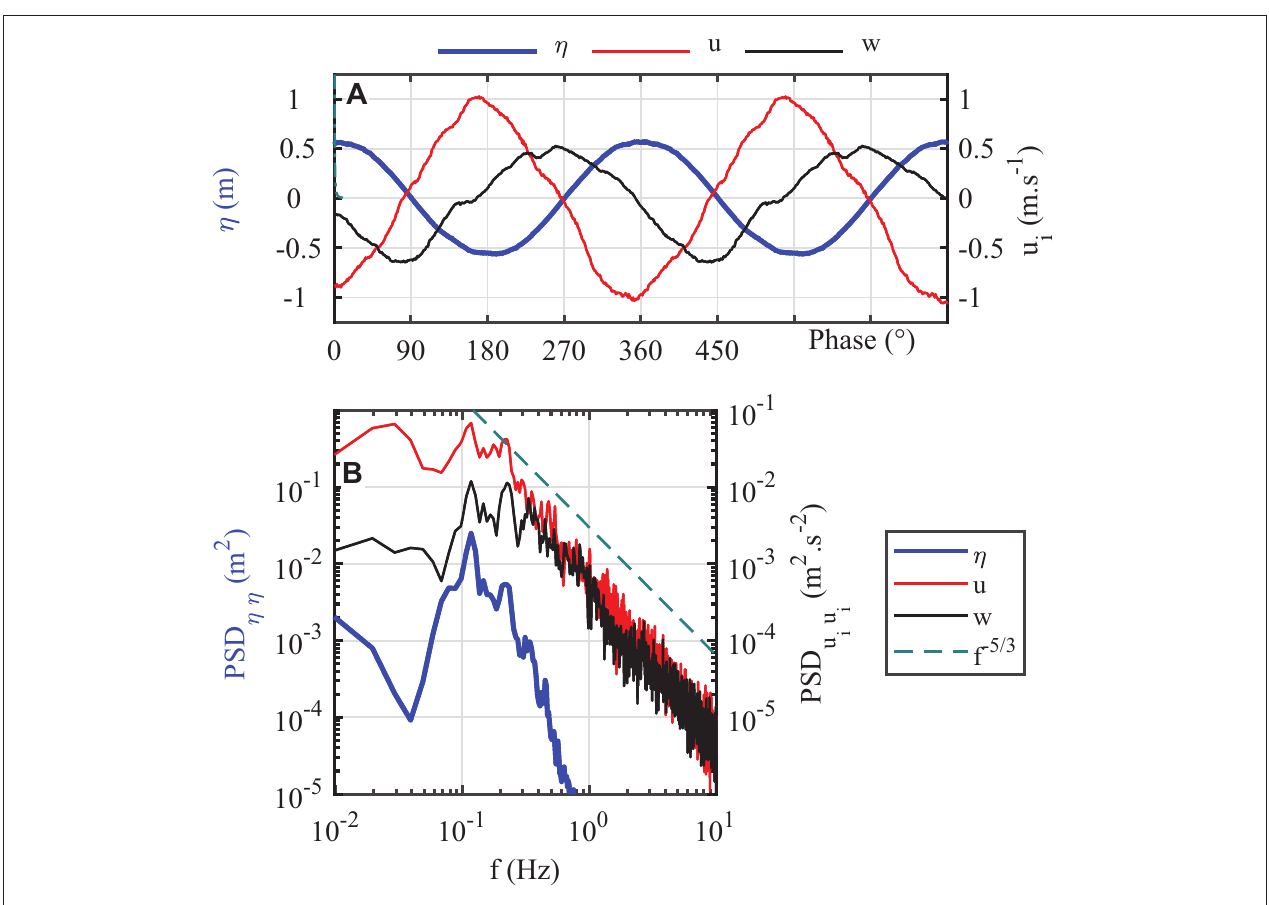
FIGURE 8 | Wind turbulence measurements from the Gill R3-50 three-dimensional ultrasonic anemometer on the SV2 Wave Glider Pascal . (A) Phase-averaged ocean surface elevation η (blue), downwind (red), and vertical (black) wind fluctuations. Phase-averaged signals were smoothed using a 30 ◦ running-average window. Downwind fluctuations are the largest and are nearly out-of-phase with the waves while vertical fluctuations are in quadrature with the waves. This is consistent with Grare et al. (2018) when measurements are performed below the critical layer. (B) Power spectral density of the surface elevation (blue) and the two wind components (red and black). Wind fluctuations follow the 5/3 Kolmogorov energy cascade (dashed line) and exhibit peaks of energy collocated with the wave energy peaks. All − data were taken from a single 6 min record starting at 1908 UTC 14 November 2013 during the SOCAL2013 experiment.